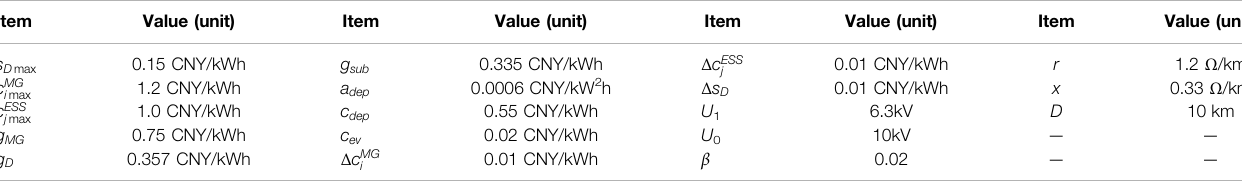
TABLE 2 | value of some corresponding